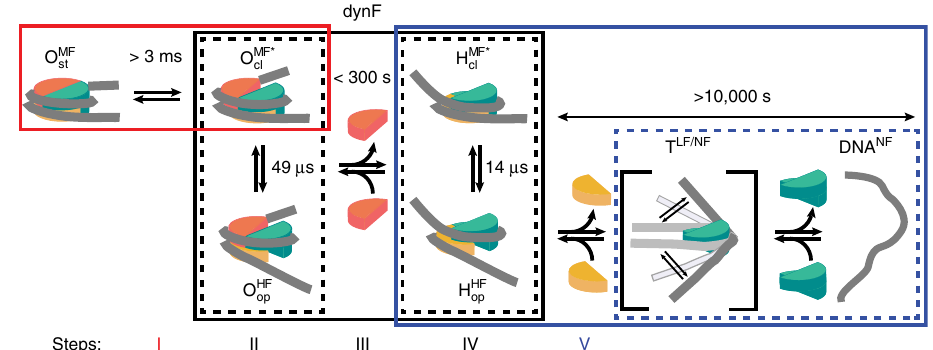
Fig. 8 Full kinetic scheme for nucleosome disassembly. At 150 mM NaCl concentration nucleosomes disassembly proceeds through the sequential loss of H2A-H2B heterodimers as presented here with the corresponding relaxation times. The two heterodimers are shown in orange ( α -side) and dark yellow ( β -side), while the tetramer is shown in turquoise. We resolve fi ve steps in our smFRET experiments: (I) Disassembly of the intact nucleosome O MF predominantly initiated from the weaker binding α -side, where opening of the fi rst dimer:tetramer interface precedes dimer eviction O MF (cid:2) second dimer can reversibly detach from the tetramer once the fi rst dimer:tetramer interface is broken O HF opening, however, is smaller when the fi rst dimer is still present, probably due to stabilizing interactions between the dimers. Once the fi rst dimer is gone H MF (cid:2) cl , reversible detachment H HF op and subsequent loss of the remaining dimer proceed at a faster rate. (V) The resulting tetrasome can adopt variable DNA geometries with most conformations leading to very low or no FRET (T LF/NF ). Note that at higher salt concentration the DNA can fully dissociate from the remaining tetramer (DNA NF ). All corresponding kinetic and thermodynamic parameters are compiled in Table 1